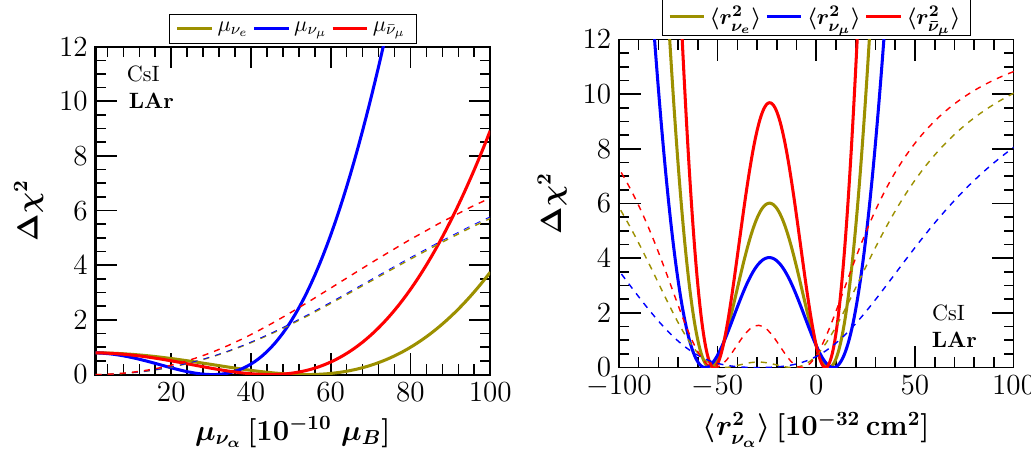
Figure 5 . Sensitivity to the neutrino magnetic moment (left) and charge radius (right). Thick (thin) curves correspond to the LAr (CsI)